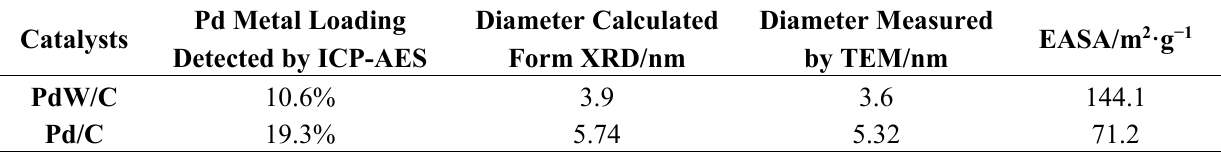
Figure 2. XRD patterns of PdW/C (1:1) and Pd/C. Table 1. Summary of physical properties of PdW/C and Pd/C